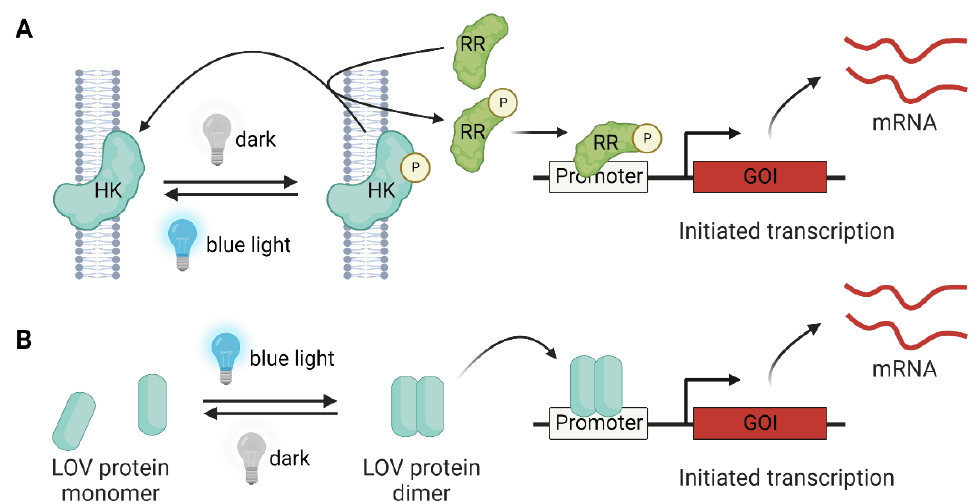
Figure 4. Light-controlled gene expression by LOV proteins. ( A ) The two-component system consists of histidine kinase (HK) and a response regulator (RR) for signal relay. In the absence of light, the HK is phosphorylated, and the phosphate group is transferred to the RR, leading to GOI expression. The blue light induces the dephosphorylation of HK and RR, and the GOI expression is inhibited. ( B ) In the one-component system, the blue-light-driven LOV dimerization (e.g., EL222) can directly trigger GOI expression.